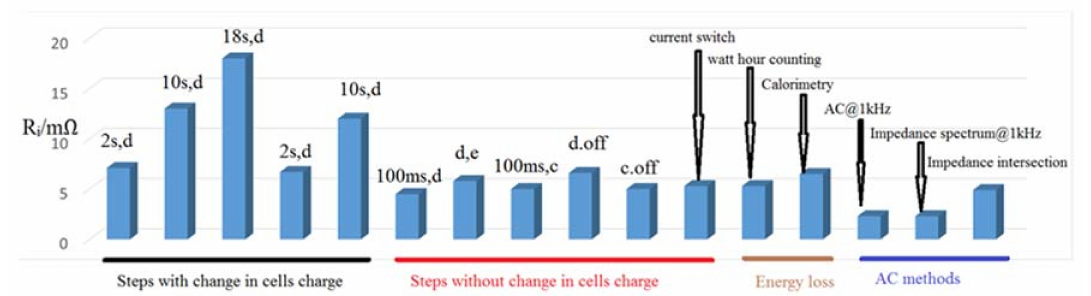
Figure 2. Internal resistance measurement with various procedures(s: seconds, d: discharge, c: charge, e: extrapolated)